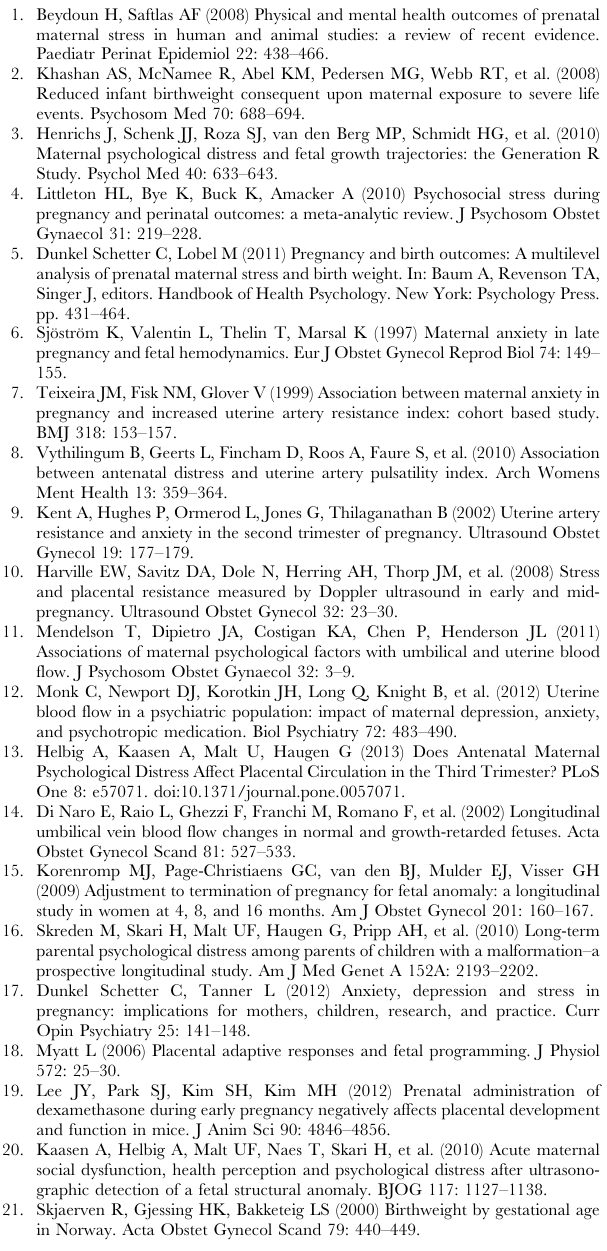
Table S2 Associations between non-psychometric co- variates and normalized umbilical vein volume blood flow (Q UVAC ; ml/min/cm) (n=